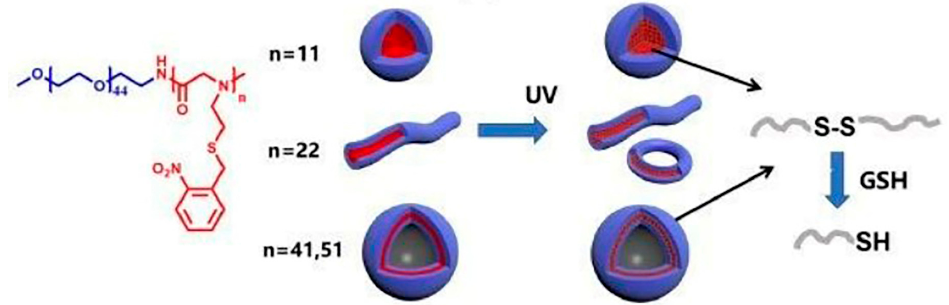
Figure 12. The reversible crosslinking assemblies from photo-responsive polypeptoids. Reprinted with permission from [98]. Copyright 2020, Royal Society of Chemistry.